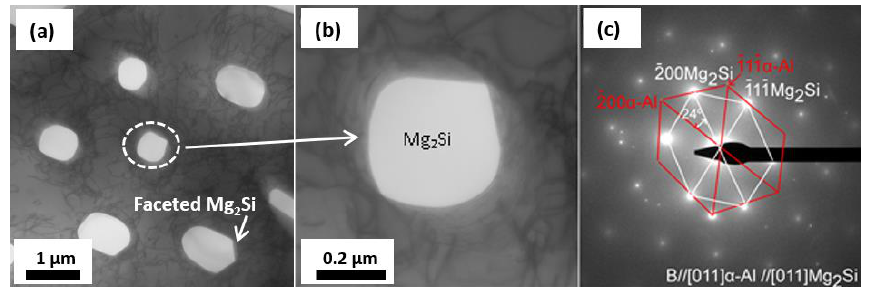
Figure 11. ( a ) bright-field TEM image showing the Al-Mg 2 Si eutectic at a lower magnification, ( b ) shows the faceted eutectic Mg 2 Si globules with a diameter of ~0.4 μm at a higher magnification and ( c ) the corresponding selected area diffraction pattern taken parallel to the electron beam direction of [011] α -Al